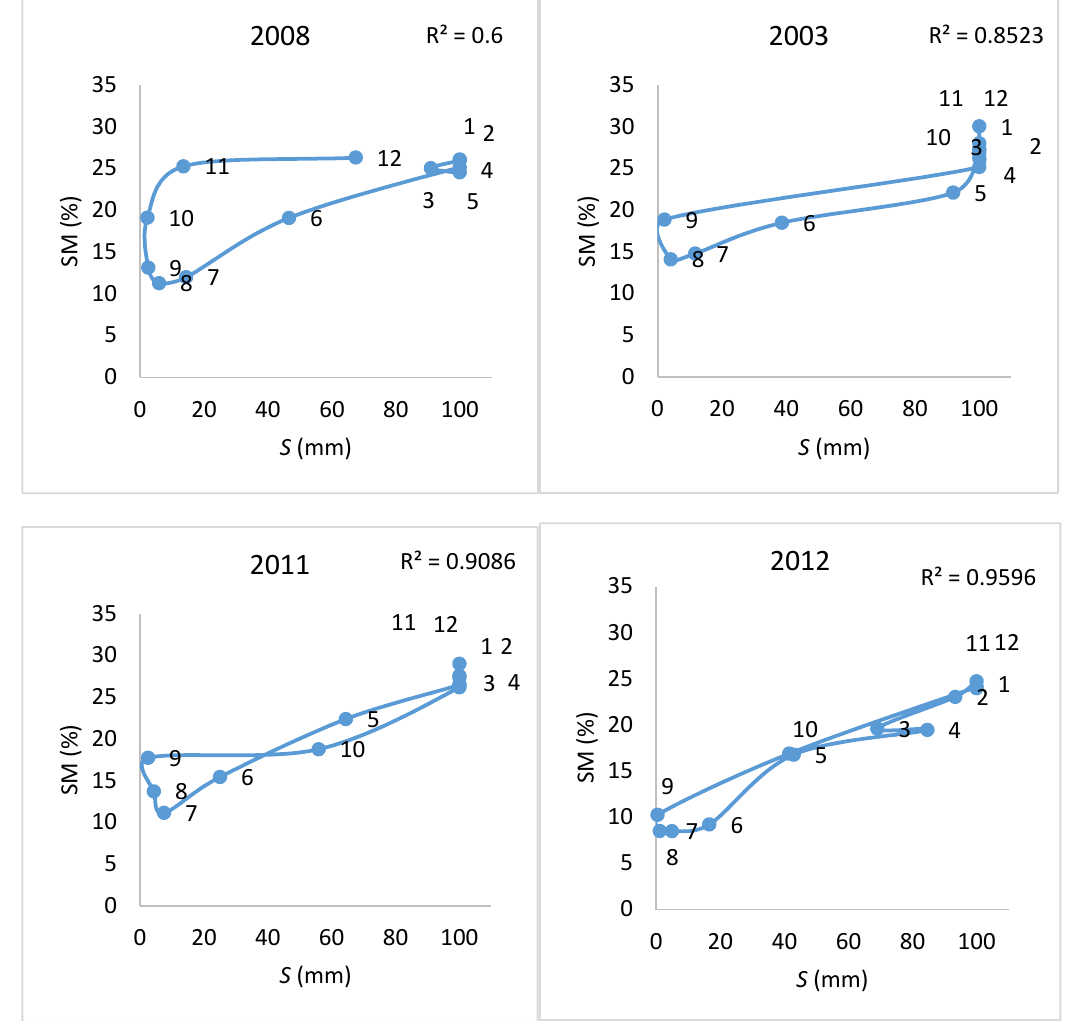
Table 3. Regression parameters and performance indicators of the logistic model applied to the segregated data series with different soil water storage capacities, Smax: segregated model (III) considering the drying and wetting subsets independently and merged (SM, %, independent vari- able; S , mm, dependent variable).